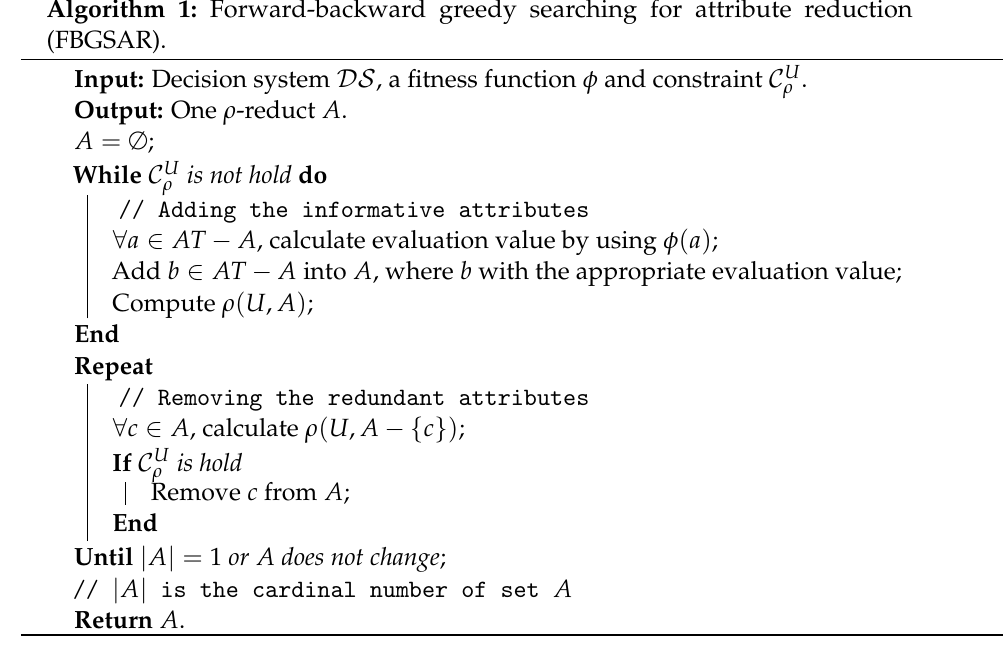
Algorithm 1: Forward-backward greedy searching for attribute